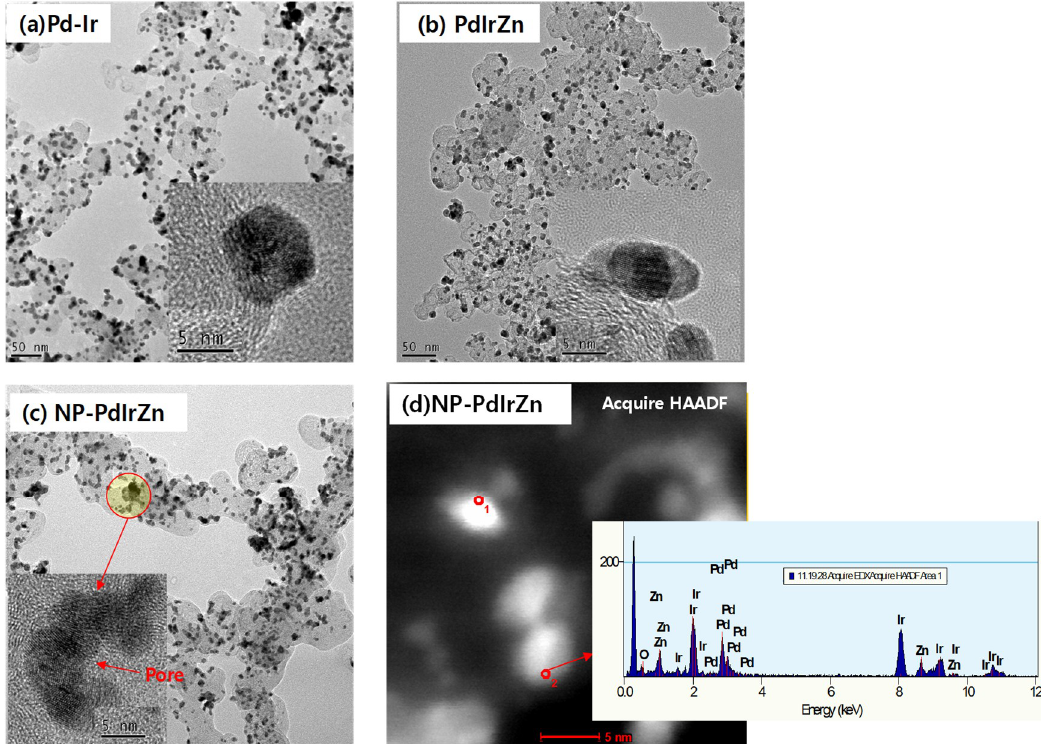
Figure 2. TEM images of ( a ) PdIr, ( b ) PdIrZn, and ( c ) NP-PdIrZn catalysts, and ( d ) TEM-EDX image of Figure 2 . TEM images of (a) PdIr, (b) PdIrZn, and (c) NP-PdIrZn catalysts, and (d) TEM-EDX image of the the NP-PdIrZn catalyst. NP-PdIrZn catalyst.